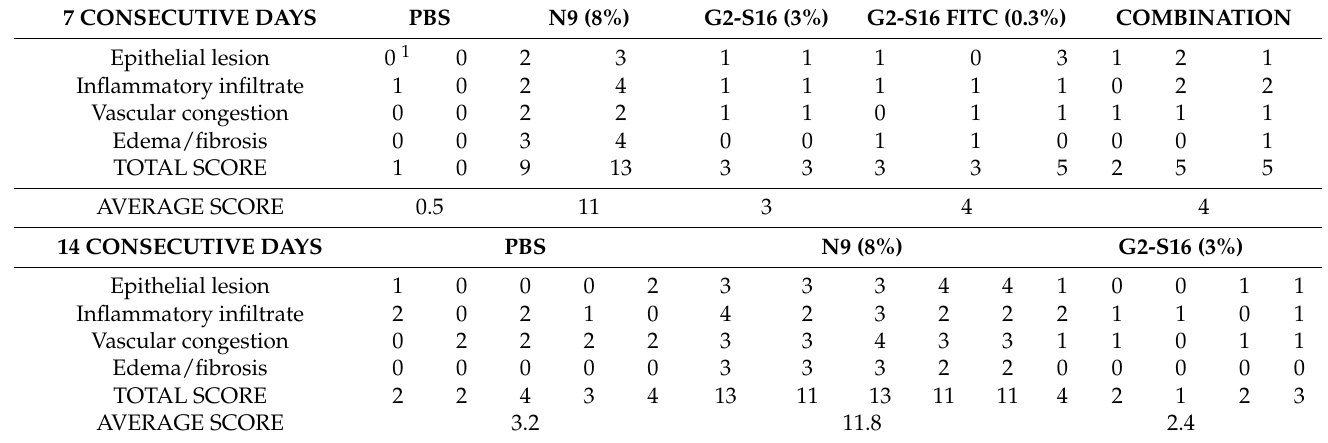
Table 1. Evaluation of tissue damage after 7 or 14 daily vaginal applications of G2-S16 dendrimer on BALB/c mice. The existence of injury in the vaginal epithelium was determined by histological evaluation after hematoxylin-eosin staining in each sample.